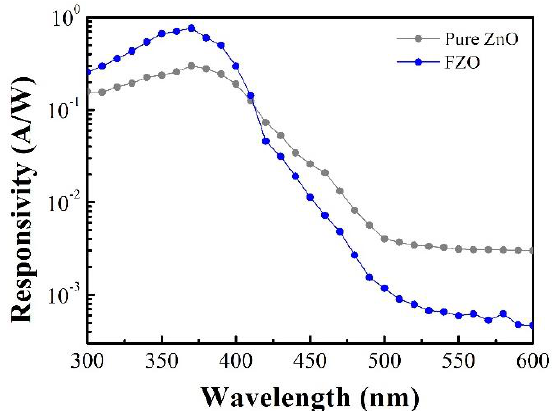
Figure 7. Measured spectral responsivities of MSM PDs based on pure ZnO and FZO NRs with an applied voltage of 3 V at room temperature.